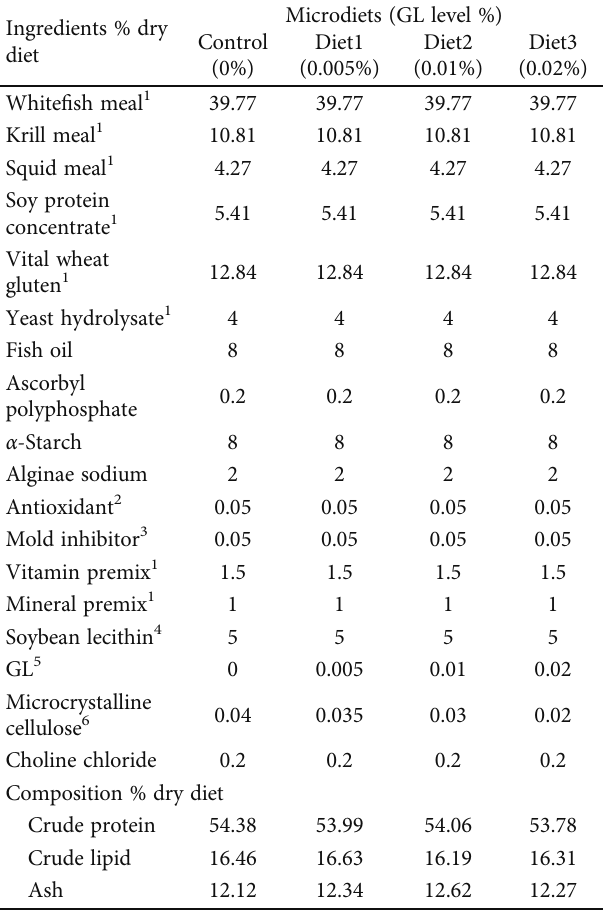
Table 1: The formulation and composition of feed trial for large yellow croaker (% dry matter).